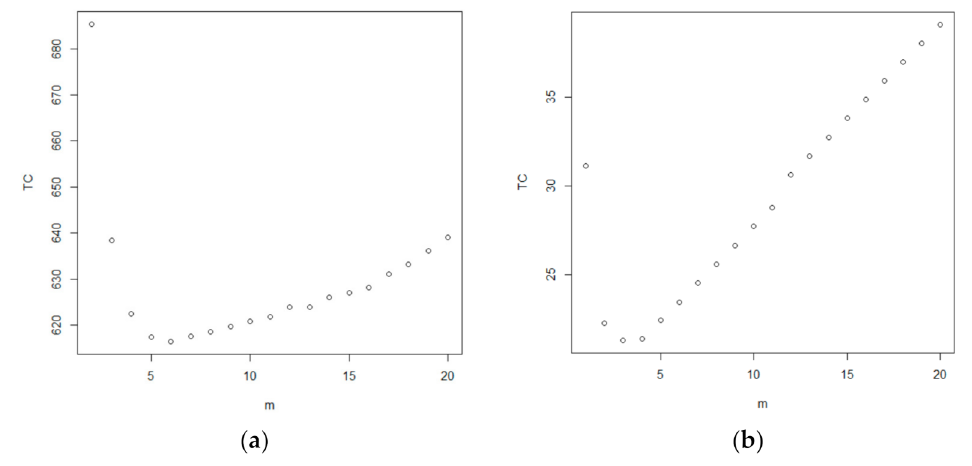
Figure 6. ( a ) Total cost curve at m = 2(1) m 0 ; ( b ) total cost curve at m = 1(1) m 0